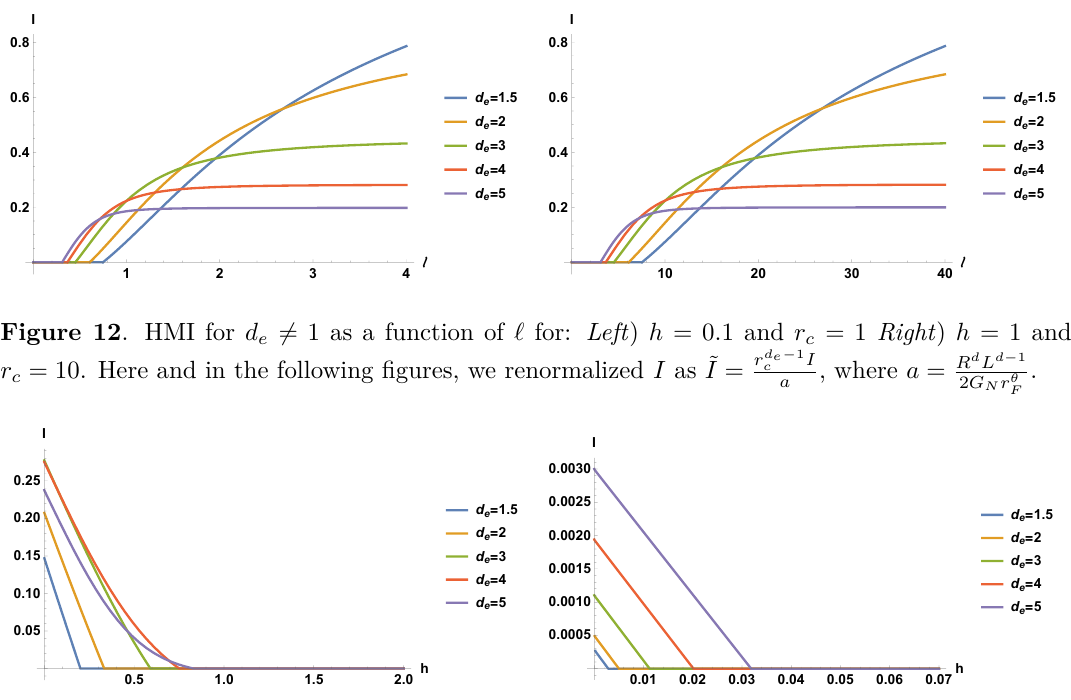
Figure 13 . HMI as a function of h for: Left ) ‘ = 1 and r c = 1 Right ) ‘ = 1 and r c = 10 . There is a critical length h at which there is a first-order phase transition in the HMI. Comparison crit . between the left and right panels, shows that for each value of d Moreover, by increasing d , h becomes larger. Furthermore, at h = 0 , the HMI is finite which is e crit in contrast to the zero cutoff